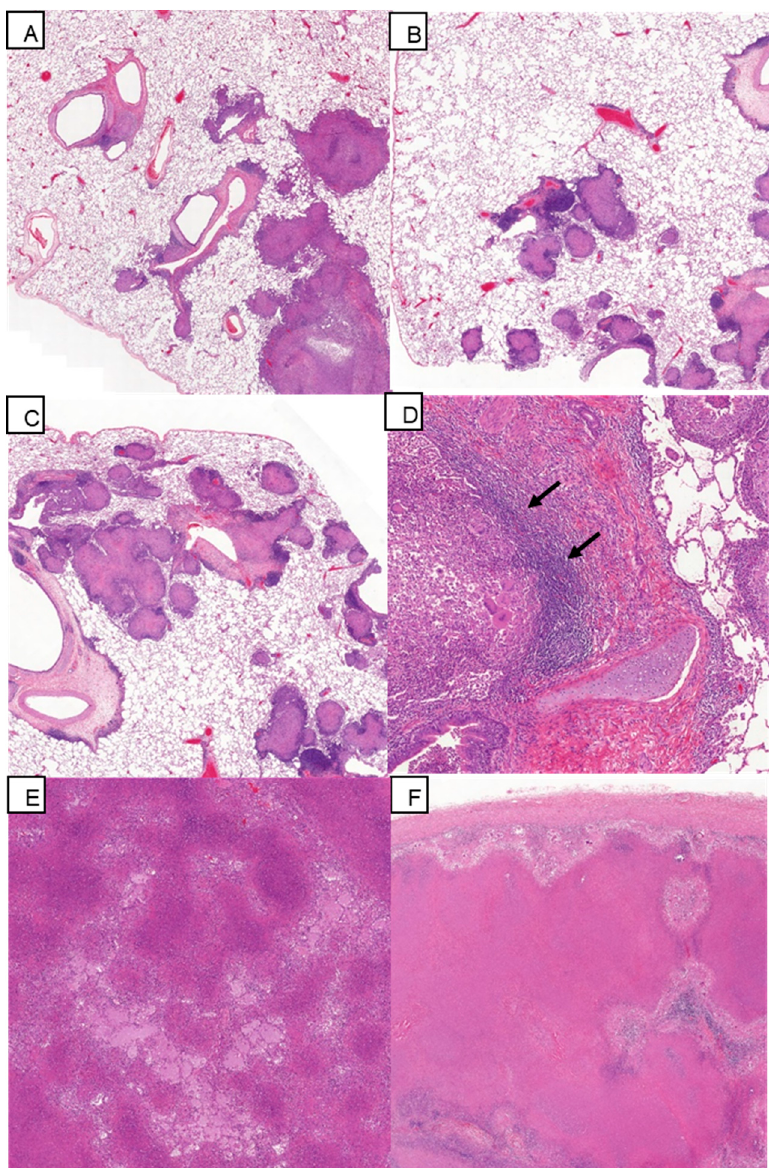
Figure 5. Microscopic changes in the lung and associated lymph node. ( A ) Lung, Animal U41 (Group A). ( B ) Lung, Animal U18 (Group B). ( C ) Lung, Animal U36 (Group C). Multifocal, tuberculous lesions of varying types scattered throughout the parenchyma. (HE, 2× objective). ( D ) Lung, Animal U58 (Group A). Bronchus-associated lymphoid tissue invaded by tuberculous granuloma, with a peripheral rim of lymphoid tissue remaining (arrows) (HE, 10× objective). ( E ) Lung, Animal U46 (Group A). Fulminating pneumonia. (HE, 5× objective). ( F ) Lung-associated lymph node, Animal U26 (Group A). Effacement of the lymphoid tissue by caseous necrosis and granulomatous inflammation. (HE, 2× objective).